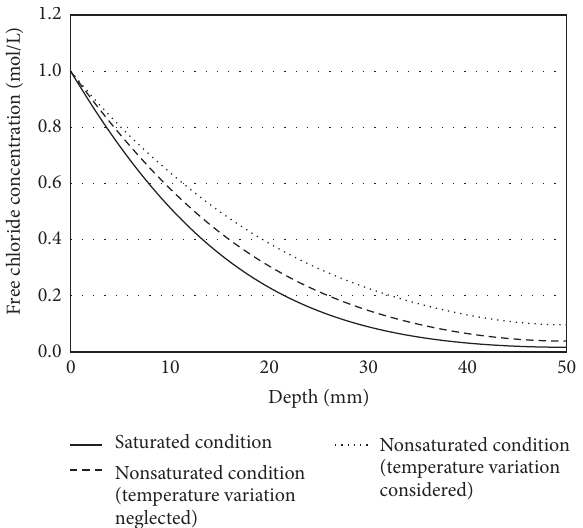
Figure 7: Free chloride concentration profiles at 50 days of expo- sure.